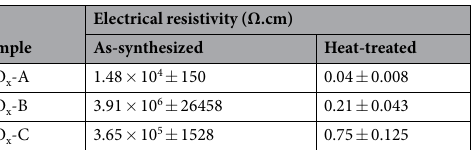
Table 1. Electrical resistivity of the samples before and after heat-treatment. The electrical resistivity of the samples significantly decreased after heat treatment. TiO x -A has the highest electrical